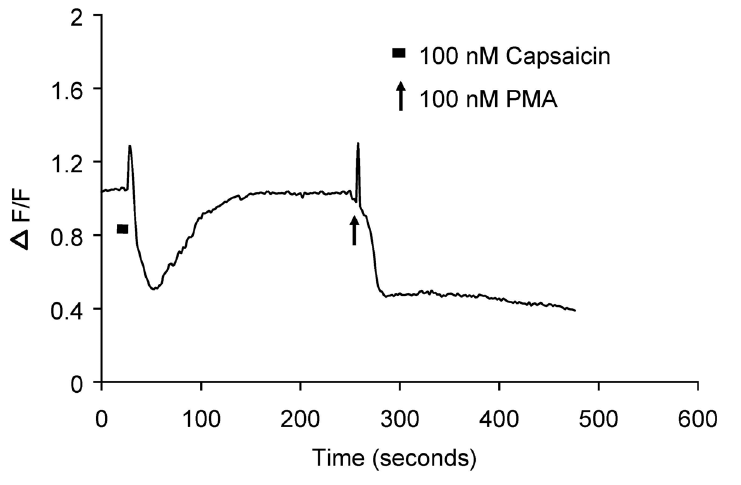
Figure 1. Translocation kinetics of PKC  II-EGFP in a single cell body of capsaicin-sensitive DRG